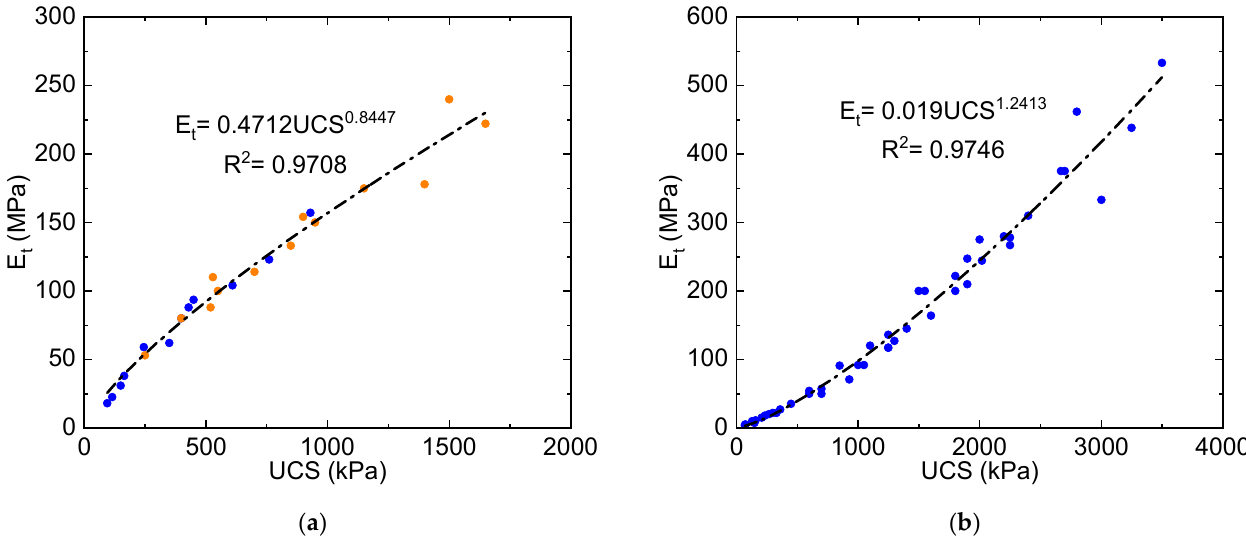
Figure 6. Relationship between E t and UCS for ( a ) Williams showing standard water contents (blue markers) and reduced water contents (orange markers), and ( b ) Macassa.